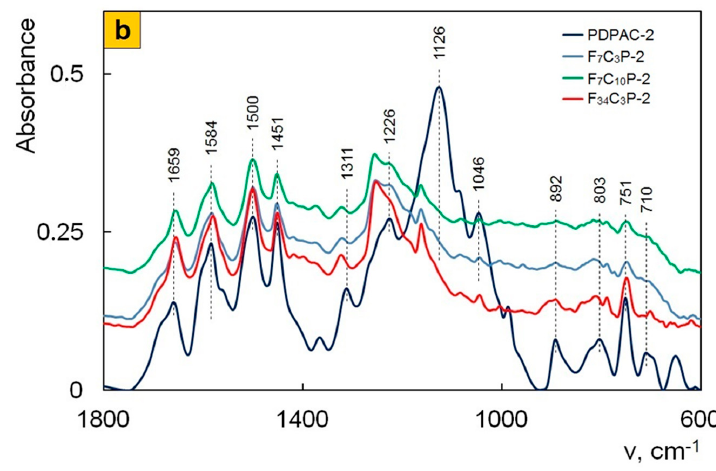
Figure 7. Attenuated total reflection (ATR) FTIR spectra of PDPAC and Fe 3 O 4 /SWCNT/PDPAC, prepared in alkaline ( a ) and acidic media ( b ).